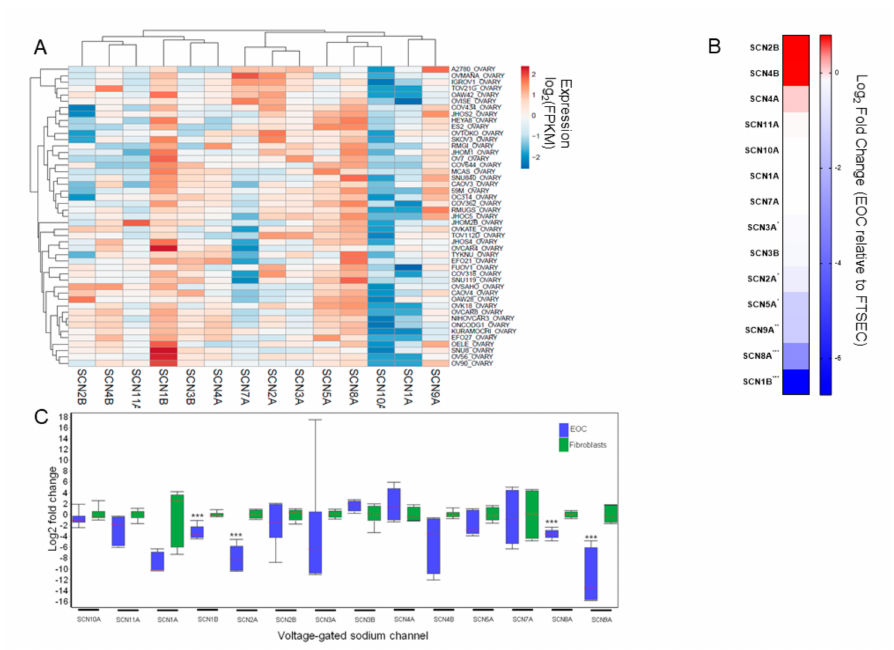
Figure 1. ( A ) Expression of voltage-gated sodium channels by RNAseq among 48 ovarian cancer cell lines in the Cancer Cell Line Encyclopedia. ( B ) Relative expression of voltage-gated sodium channels by RNAseq in epithelial ovarian cancer cells (EOC) compared to fallopian tube secretory epithelial cells (FTSEC). ( C ) Box and whisker plots showing relative expression of voltage-gated sodium channels by qRT-PCR in EOC versus fibroblasts. *** p < 0.001 Adjusted for multiple